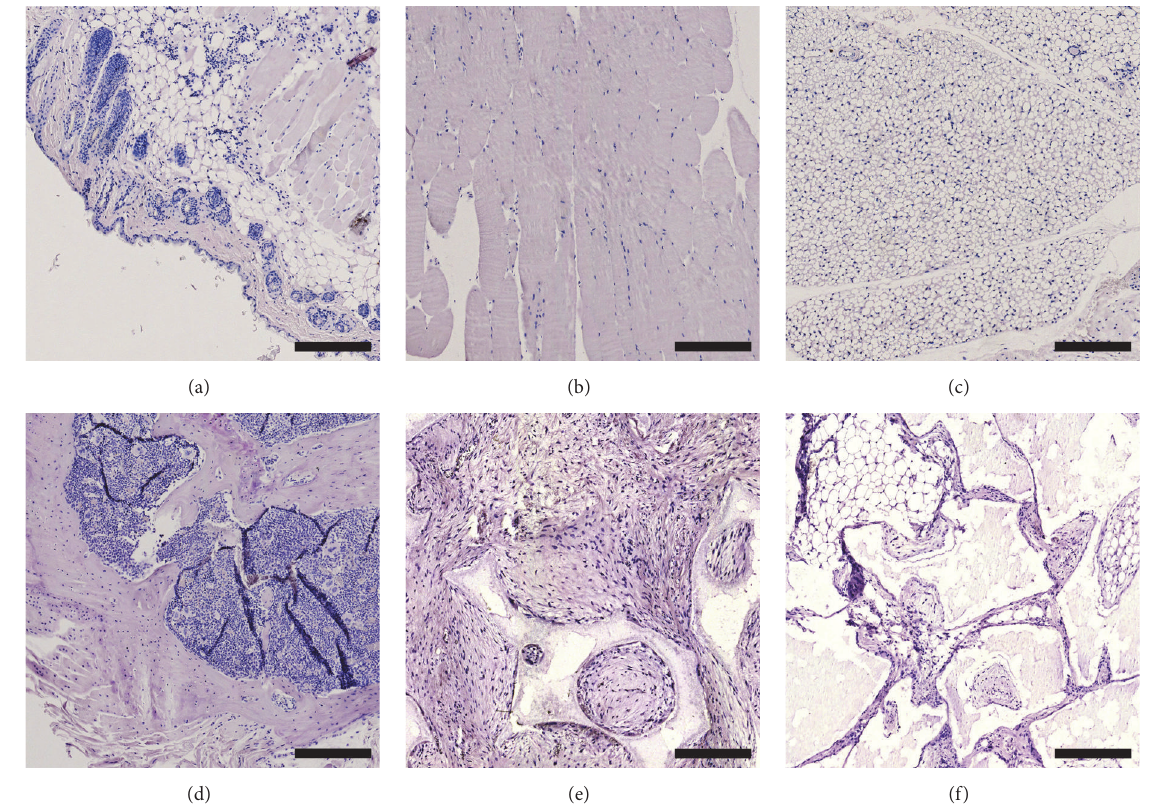
Figure 5: Tissue samples from skin (a), muscle (b), adipose tissue (c), and bone (d), an implant without primary antibody (e), and an implant without cells (f). All samples are HVIM − . Scalebar: 250 𝜇